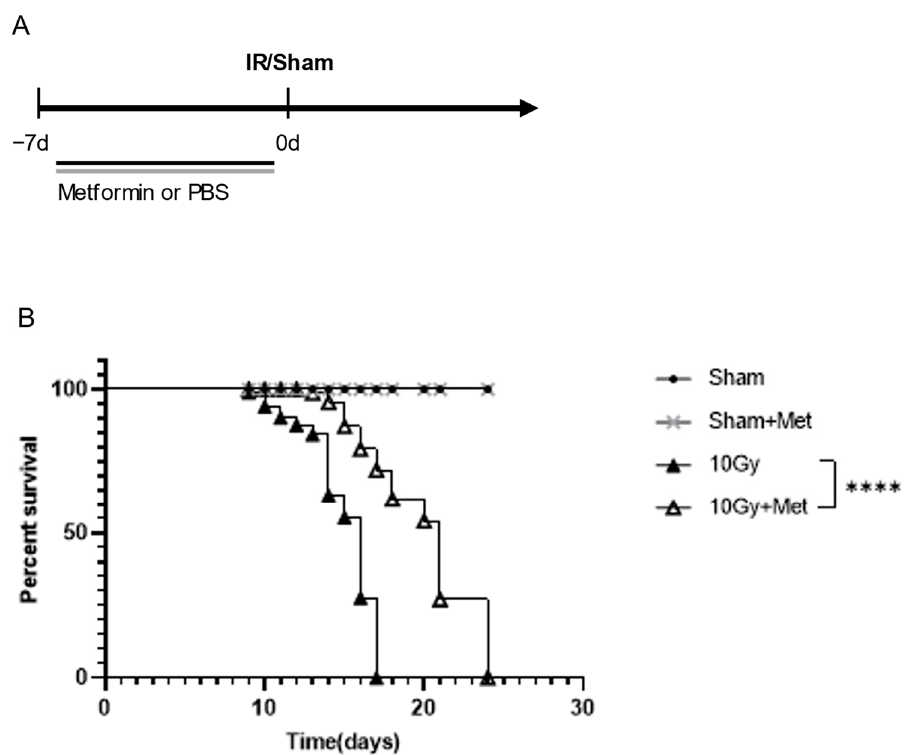
Figure 1. Metformin can reduce the mortality rate in mice exposed to γ -irradiation. ( A ) Overview of experimental timeline. IR, irradiation; PBS, phosphate buffer solution; d, day. ( B ) Survival curves for the mice by whole body exposure of 10 Gy γ -irradiation (n = 17). Met, metformin. **** p < 0.0001.